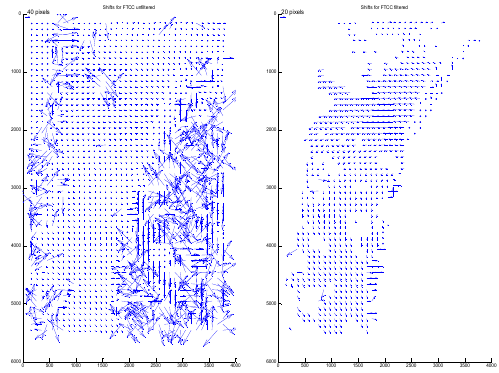
Figure 12. The computed shifts from FTCC without any filtering (left) and after the filtering procedure (right) when keeping the 40% matches with the best score.